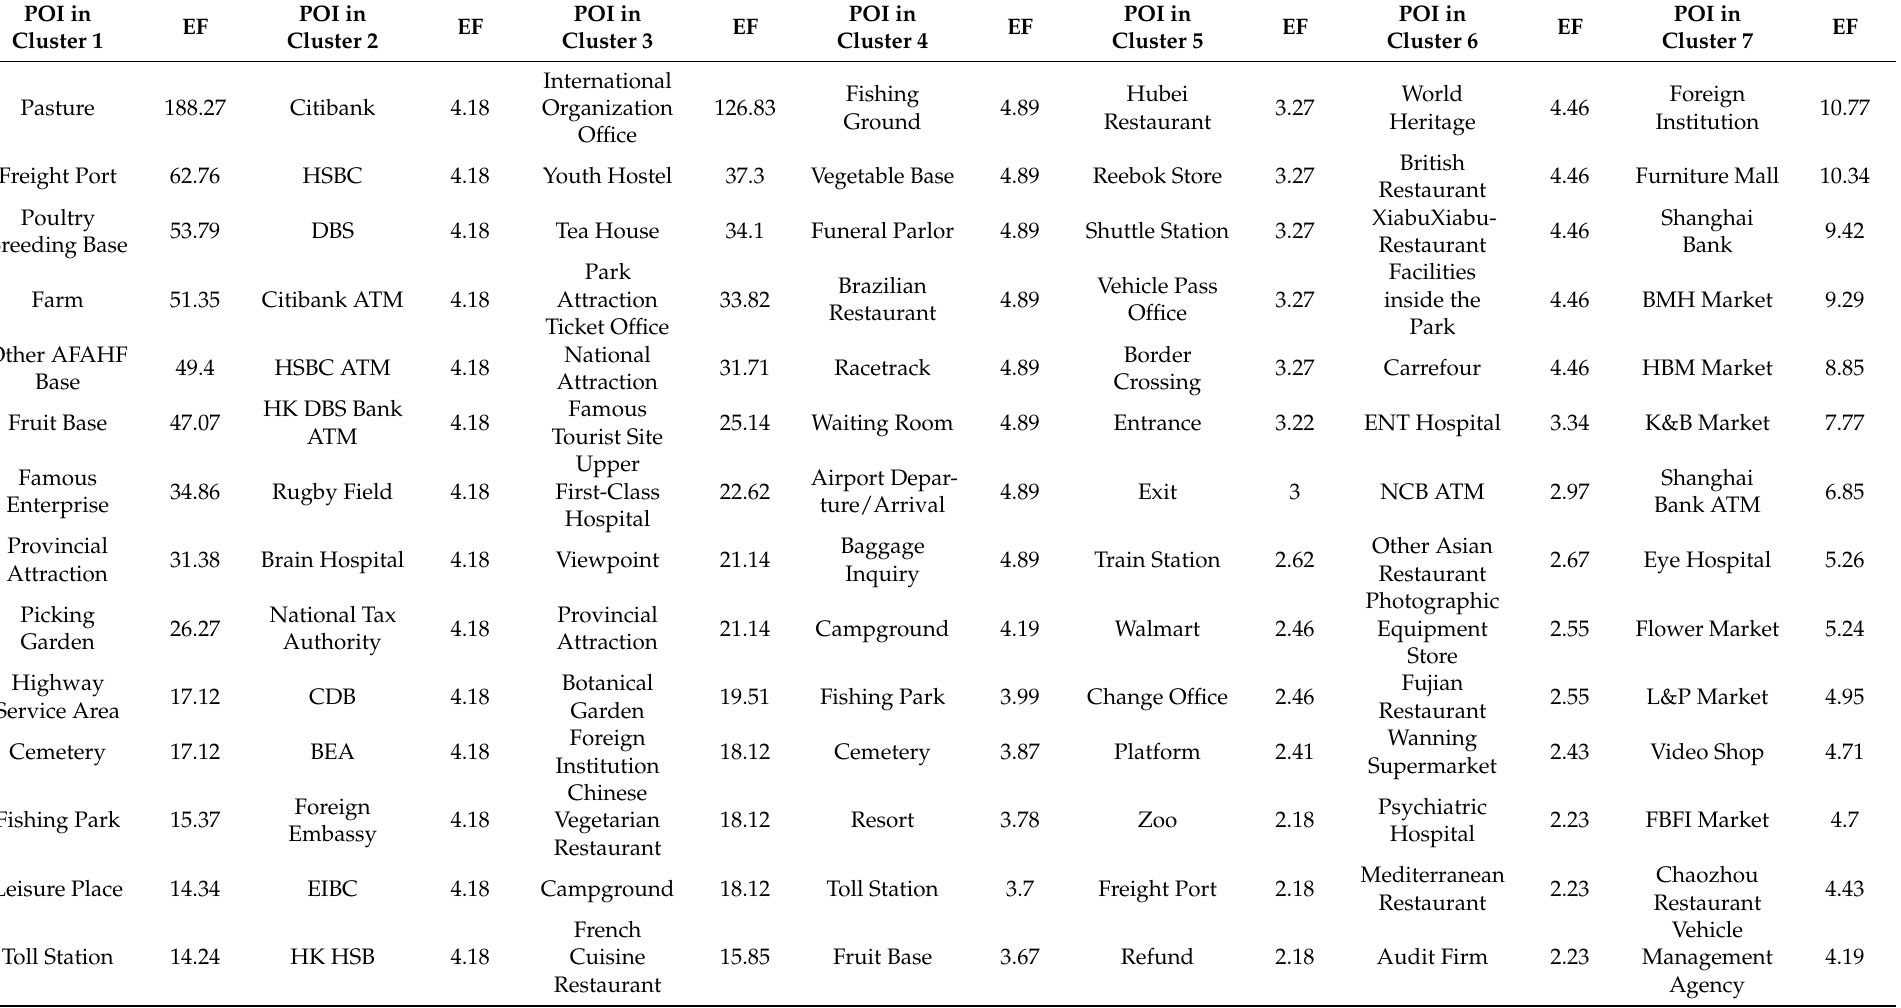
Table 5. Top 20 POI types by EF in each